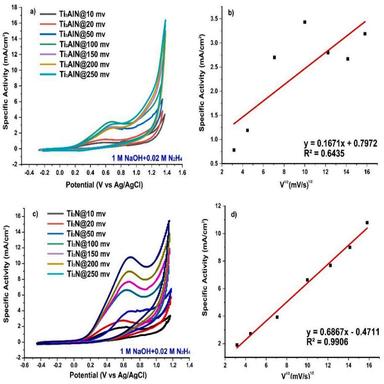
CVs of a,b) Ti2AlN and c,d) Ti2NTx at varying scan rates.